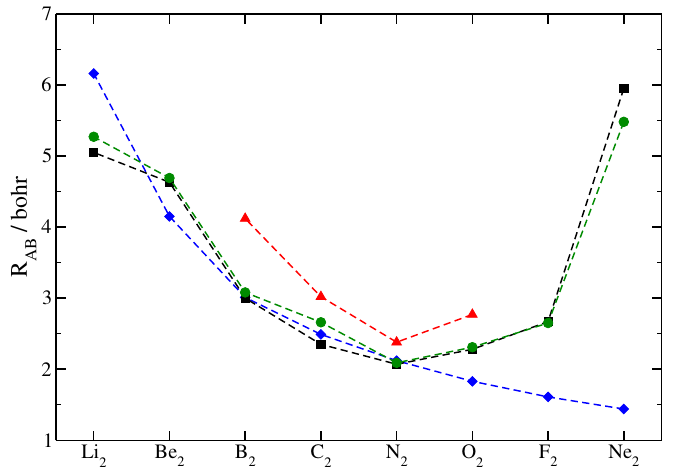
Figure 2. Equilibrium bond length for second-row homonuclear dimers. Black squares: Experimental values [67,68], green circles: Kohn–Sham calculations from ADF/LDA/QZ4P level, blue diamonds: OF-DFT using the bare atomic fragment approach (some of the data previously published here [54]), red triangles: OF-DFT using the deformation potential and electron counts from MO